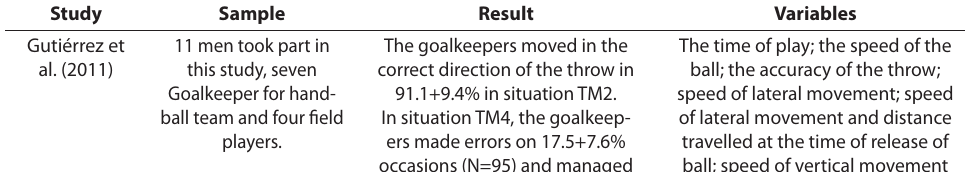
TABLE 1 Studies with descriptive analysis Study Sample Result